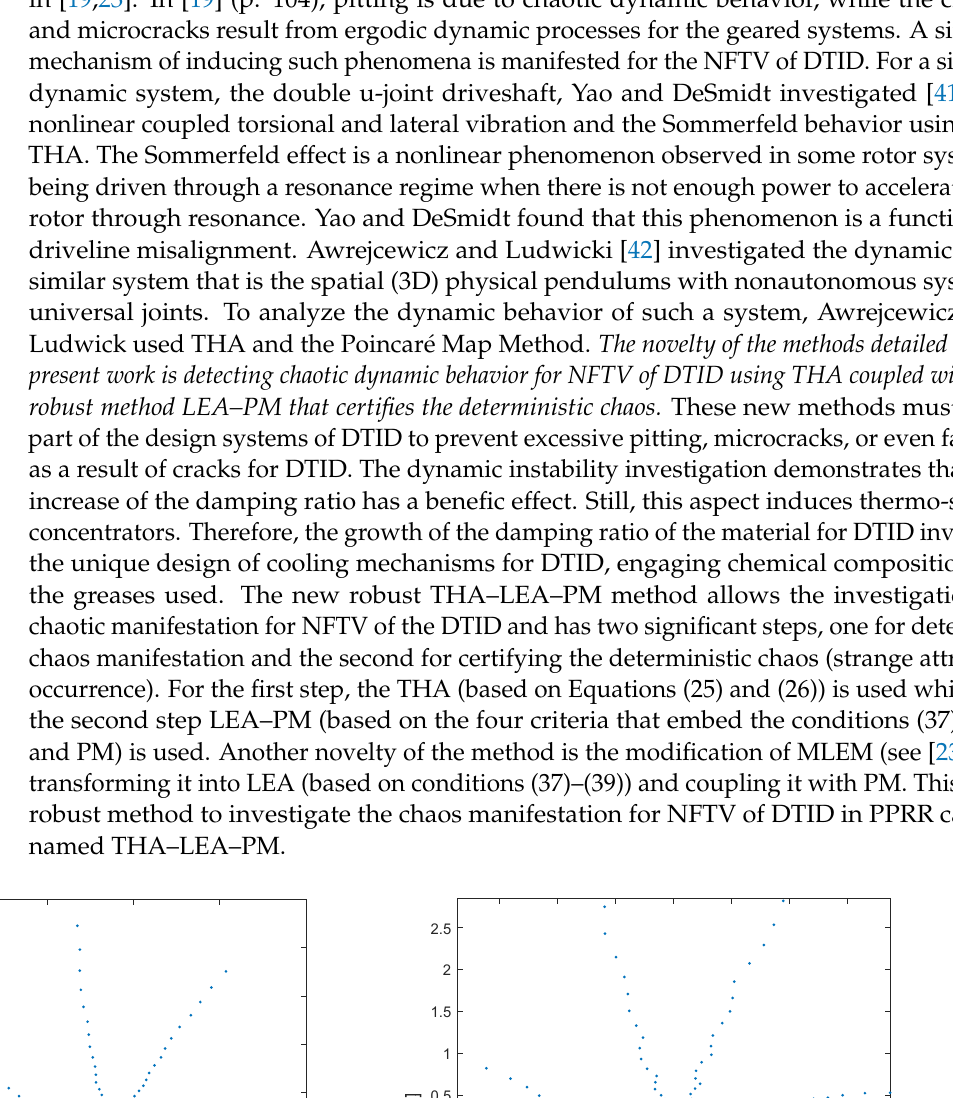
( b ) Figure 29. Poincaré Map of DOE3 for